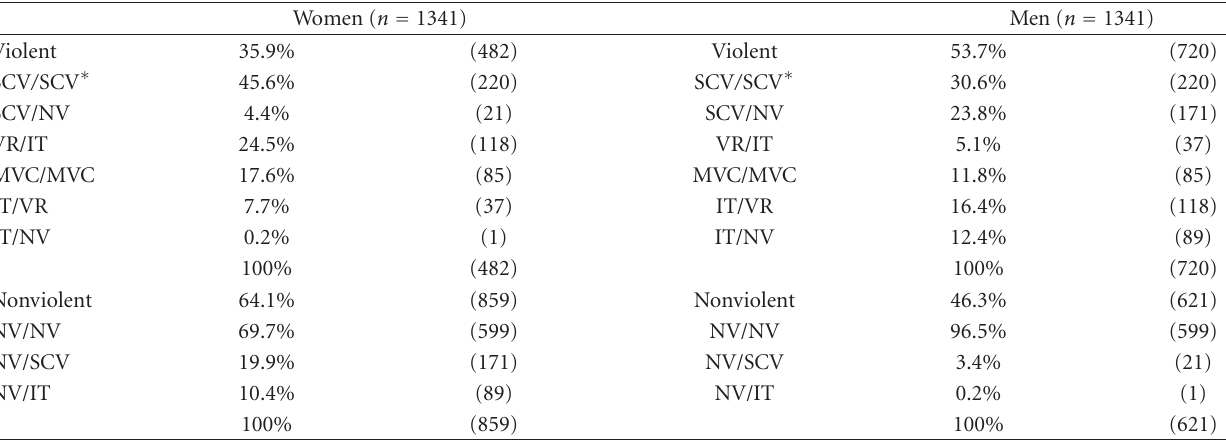
Table 1: Violence types by gender.